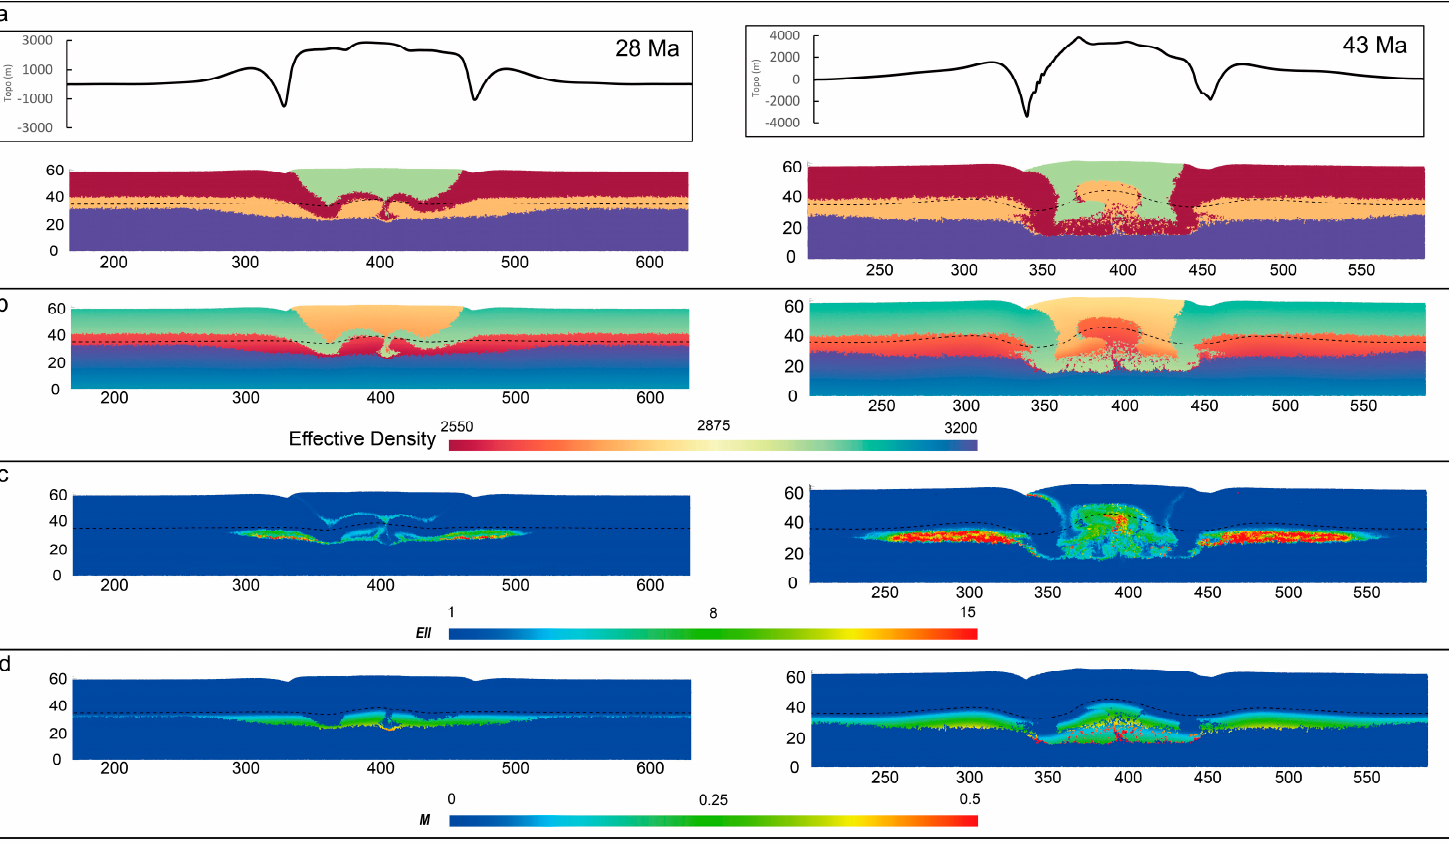
ε II · ∆ t ). ( d ) Melt fraction 0